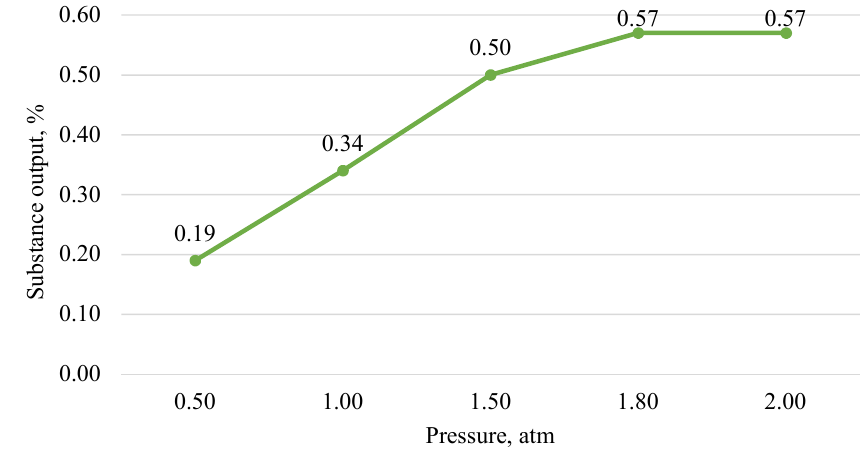
Fig. 6. Graph of dependence of essential oil yield on the pressure